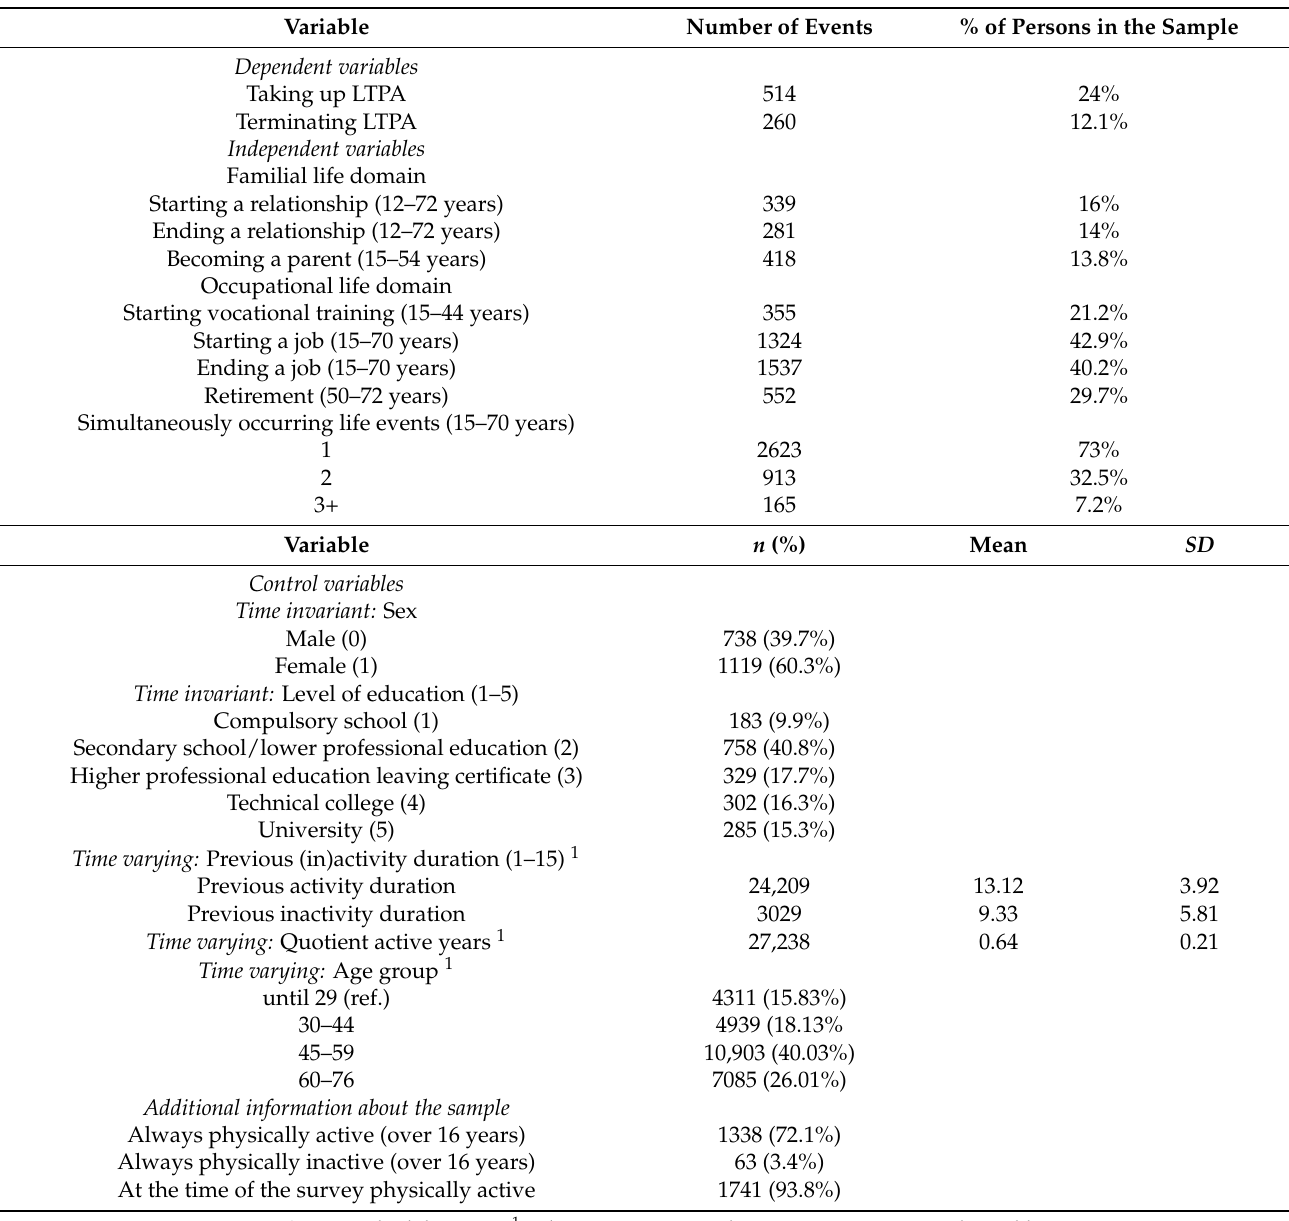
Table 1. Descriptive data for the entire sample n = 1857 persons over 16 years (total n = 27,238